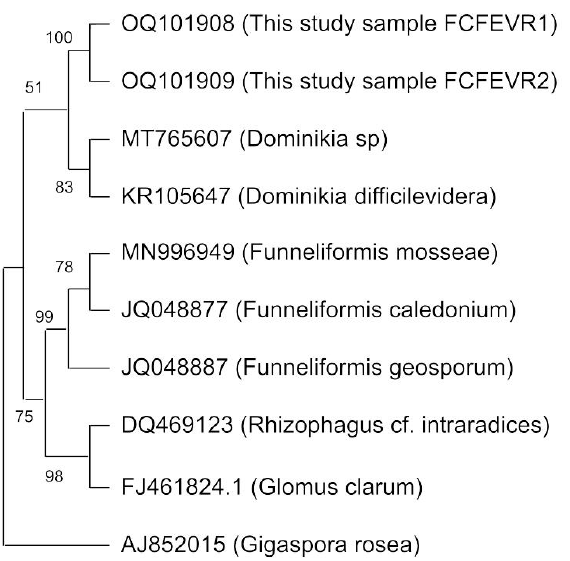
Figure 5. Phylogenetic tree constructed with a maximum parsimony analysis of taxa with the obtained sequences of closely related arbuscular mycorrhizal fungi species. References: the branches corresponding to partitions reproduced in >50% of bootstrap replicates are collapsed. The percentage of replicate trees in which the associated taxa clustered together in the bootstrap test (200 replicates) is shown next to the branches. (Sequences are available at http://www.ncbi.nlm.nih.gov/; accessed, 1 December 2022).